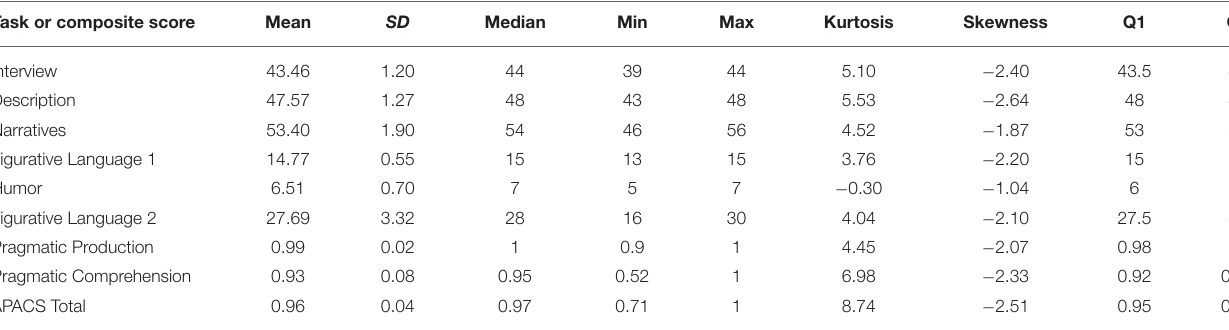
TABLE 2 | Descriptive statistics of APACS